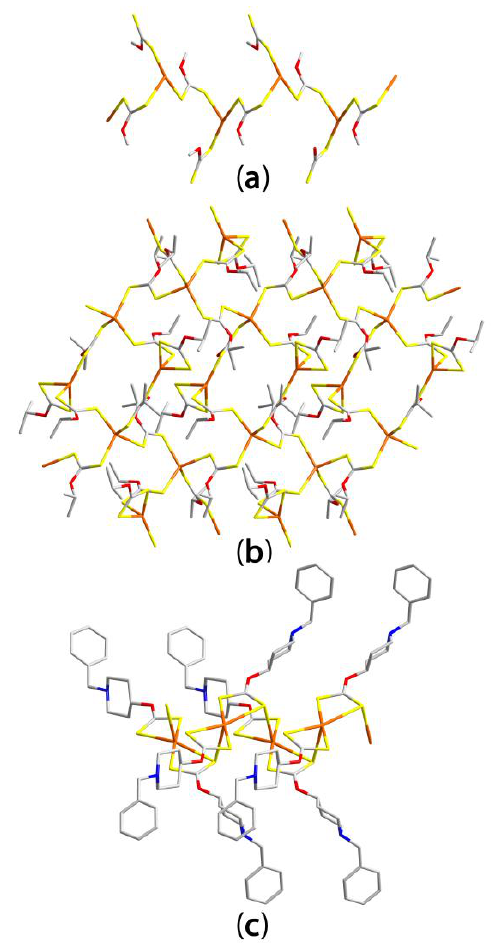
Figure 4. Aggregation in the crystals of ( a ) [Hg(S 2 COMe) 2 ] n ( 11 ); ( b ) [Hg(S 2 CO-i-Pr) 2 ] n ( 15 ); and ( c ) [Hg{S 2 COC(H)[(CH 2 ) 2 ] 2 NCH 2 Ph} 2 ] n ( 20 ). Additional colour code: nitrogen, blue.